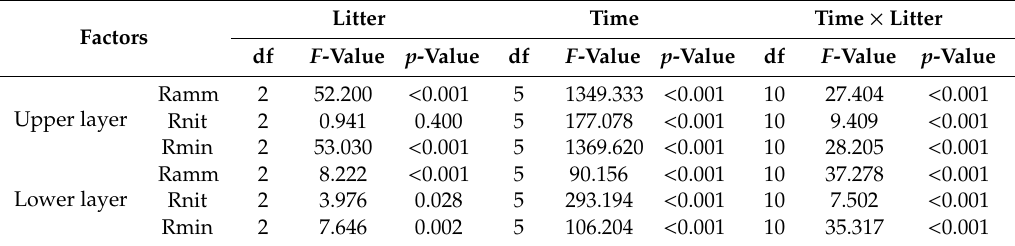
Table A2. Results of two-way repeated measures ANOVA concerning the e ff ects of sampling time, litter manipulation and the interaction between sampling time and litter manipulation on the rates of soil net N mineralization in the upper layer and lower layer of the Larix gmelinii forest.